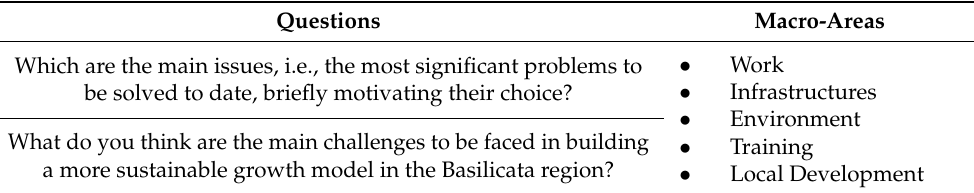
Table 3. The two open questions addressed to the other social actors.